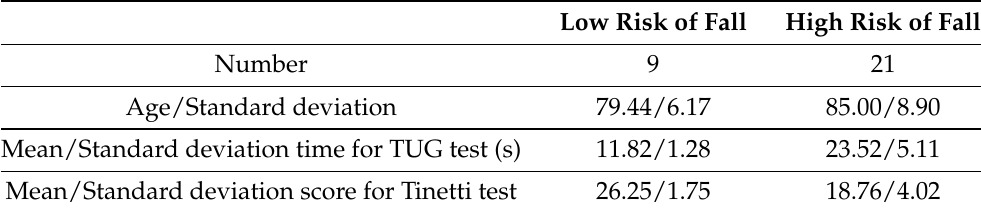
Table 1. Descriptive statistics about the low and high fall risk groups.